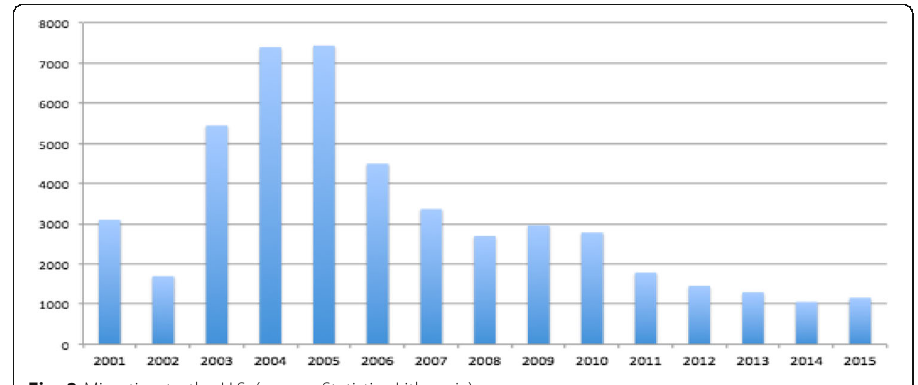
Fig. 2 Migration to the U.S. (source: Statistics Lithuania)